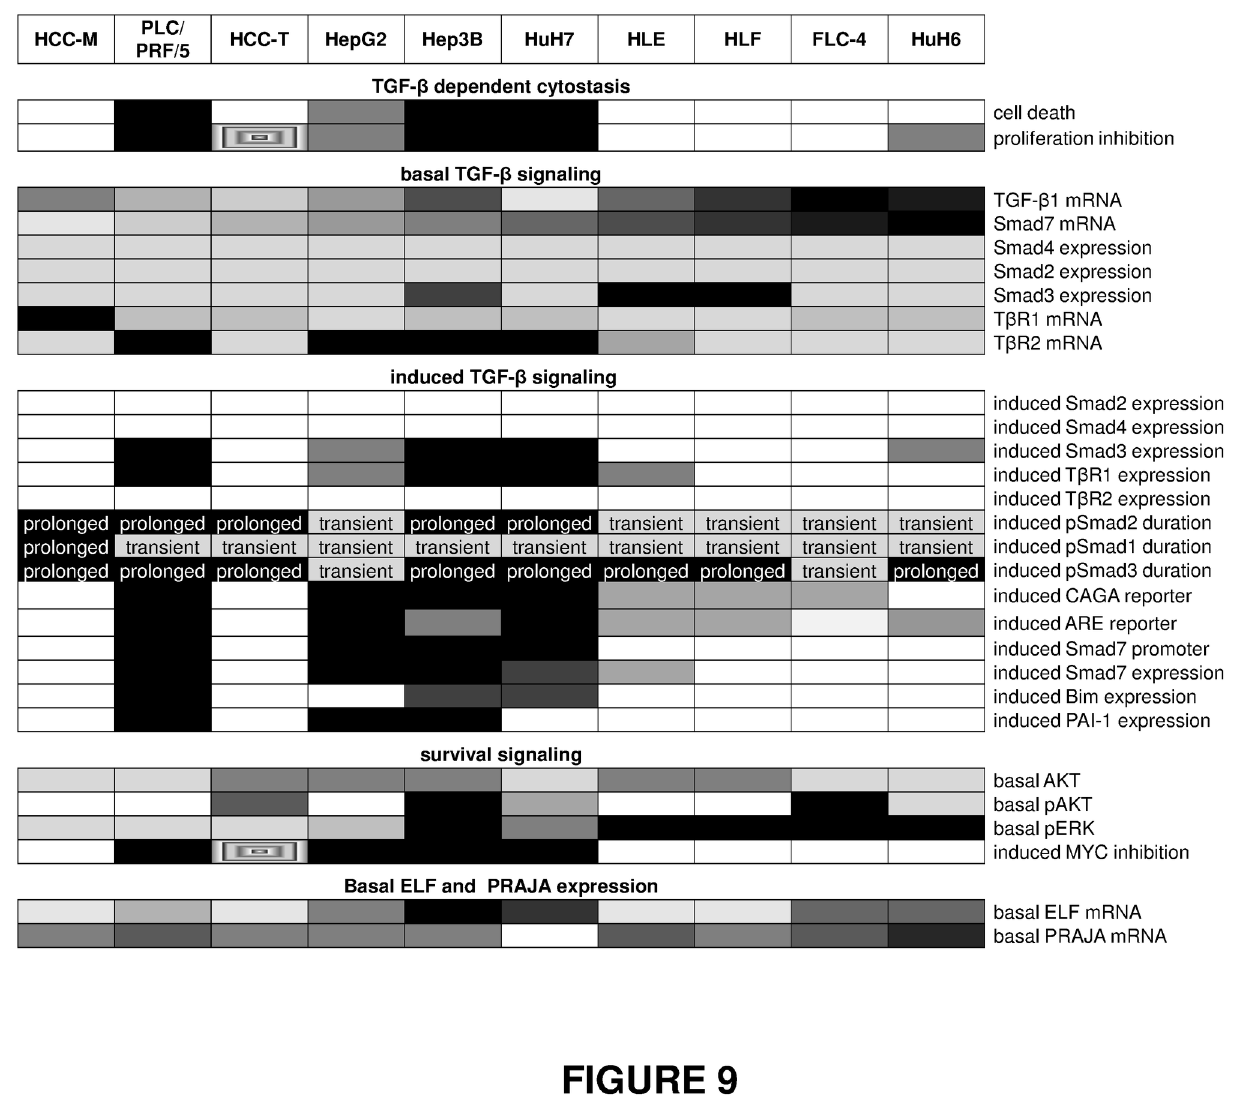
Figure 9. Overview of basal expression levels and TGF-β response in 10 different liver cancer cell lines. TGF-β dependent cytostasis, induced TGF-β signalling and inhibition of MYC expression: Here, the table gives an overview about TGF-β induced effects. The darker the field, the stronger is or, as for proliferation inhibition, the earlier occurs the described response. Basal TGF-β signalling, survival signalling and ELF and PRAJA expression: Basal expression and protein levels of various genes were analyzed. The results are interpreted with different gray scales with increasing darkness for higher expression levels. Scattered fields display cells which react contradictory to the described effect. The overview highlights some correlations found by the experiments described in Figures 1-6: a) Except for HuH6 cells, cell lines with a cytostatic response show similar responses: Strong TGF-β dependent increase in Smad3 and TβR1 expression and activation of Smad7 and Smad3 promotor activity. The latter one is mirrored in an induction of Smad3 target gene expression (Bim and PAI-1). b) Smad7 expression correlates to TGF-β1 mRNA, the duration of the Smad2 activation, but also to basal ERK phosphorylation. c) In many cases HCC-M and HCC-T cells show completely different features compared to cell lines with similar Smad7